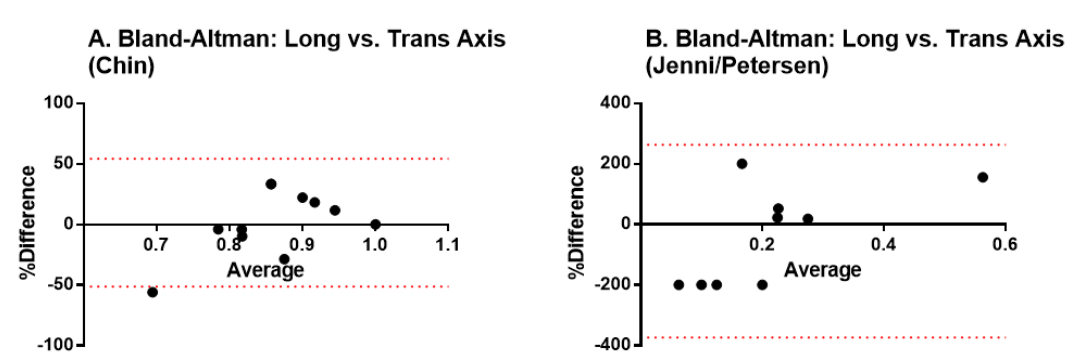
Figure 2. Bland-Altman tests to validate the agreement between measurements performed in the short versus the long axis of the heart. ( A ) transversal axis; ( B ) longitudinal axis